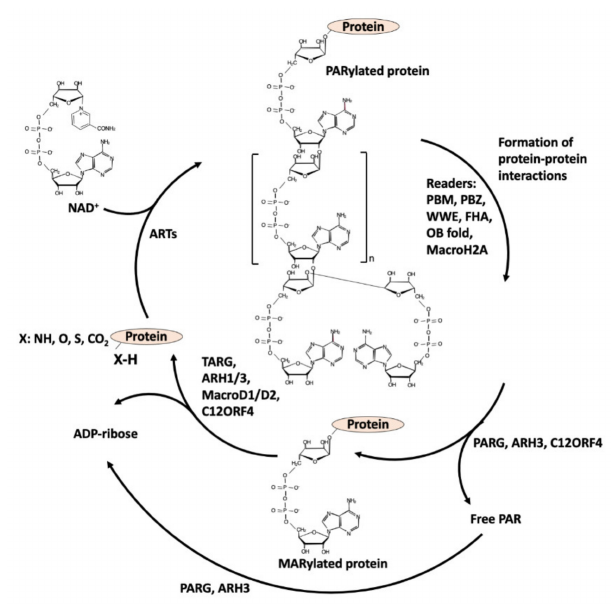
Figure 2. PARylation cycle: writers, readers, and